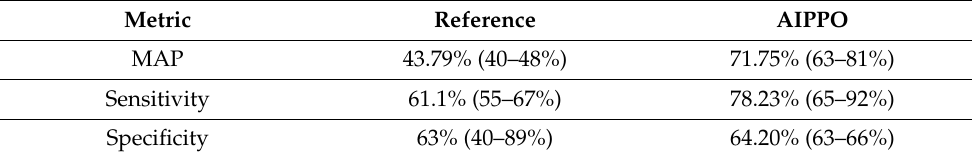
Table 4. Performance measured for AIppo system in phase